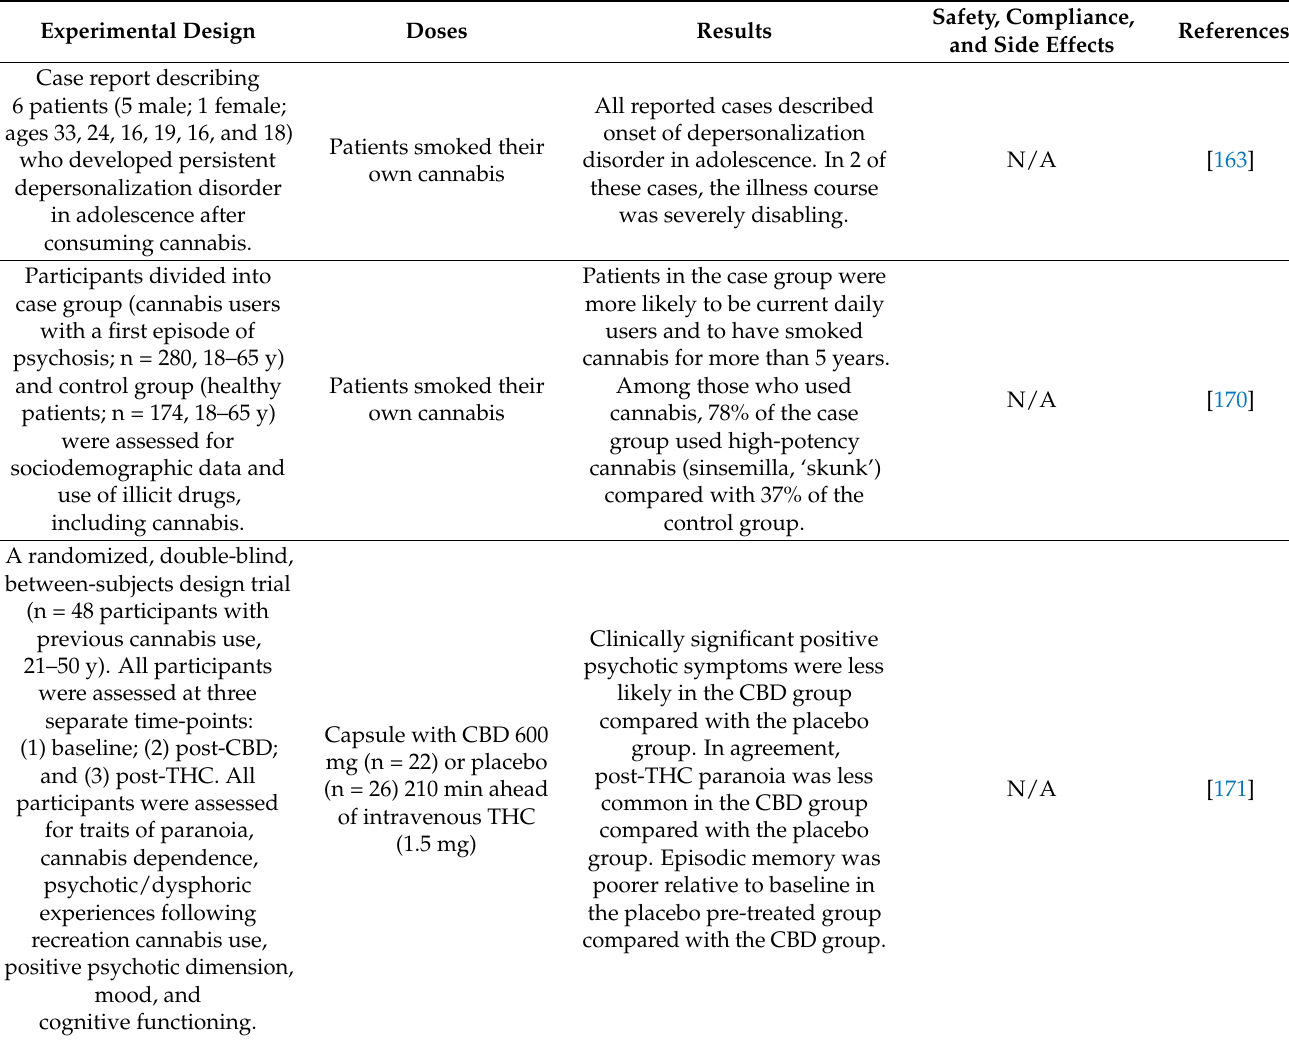
Table 1. Clinical trials evaluating the effects of THC and CBD on neuropsychiatric disorders in adults (white rows) and adolescents (light-grey